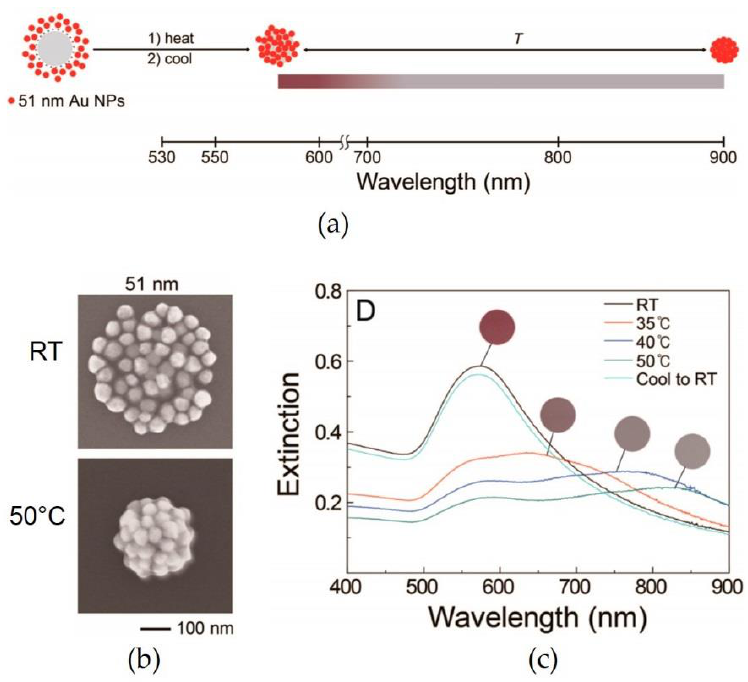
Figure 3. ( a ) Scheme of the temperature-assisted control over the Au NP assembly supported in a PNIPAM gel; ( b ) SEM images of the poly( N -isopropylacrylamide) (PNIPAM) gels observed at room temperature (RT) and at 50 °C; and ( c ) UV–Vis spectra of the gels measured at various temperatures. Reproduced with permission from Reference [52] (Copyright 2014 American Chemical